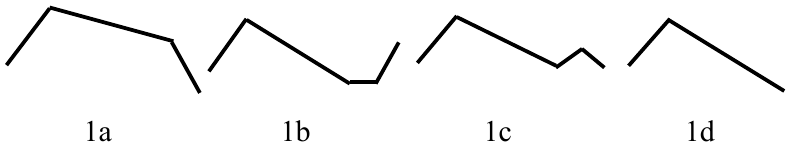
Figure 1. Wh-question configurations according to Navarro Tomás (1950) (1a-1c) and Quilis (1993)